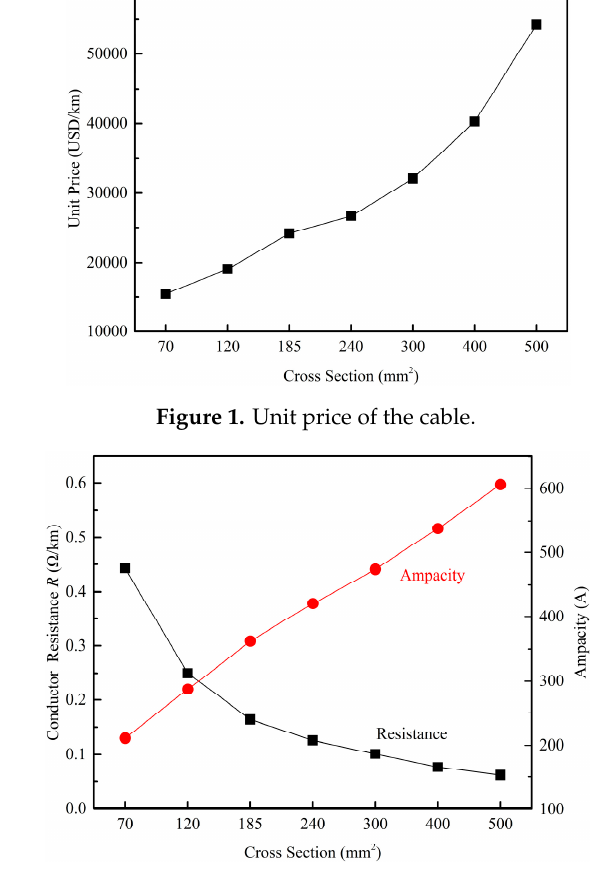
Figure 2. Resistance and current-carrying capacity of the cable.